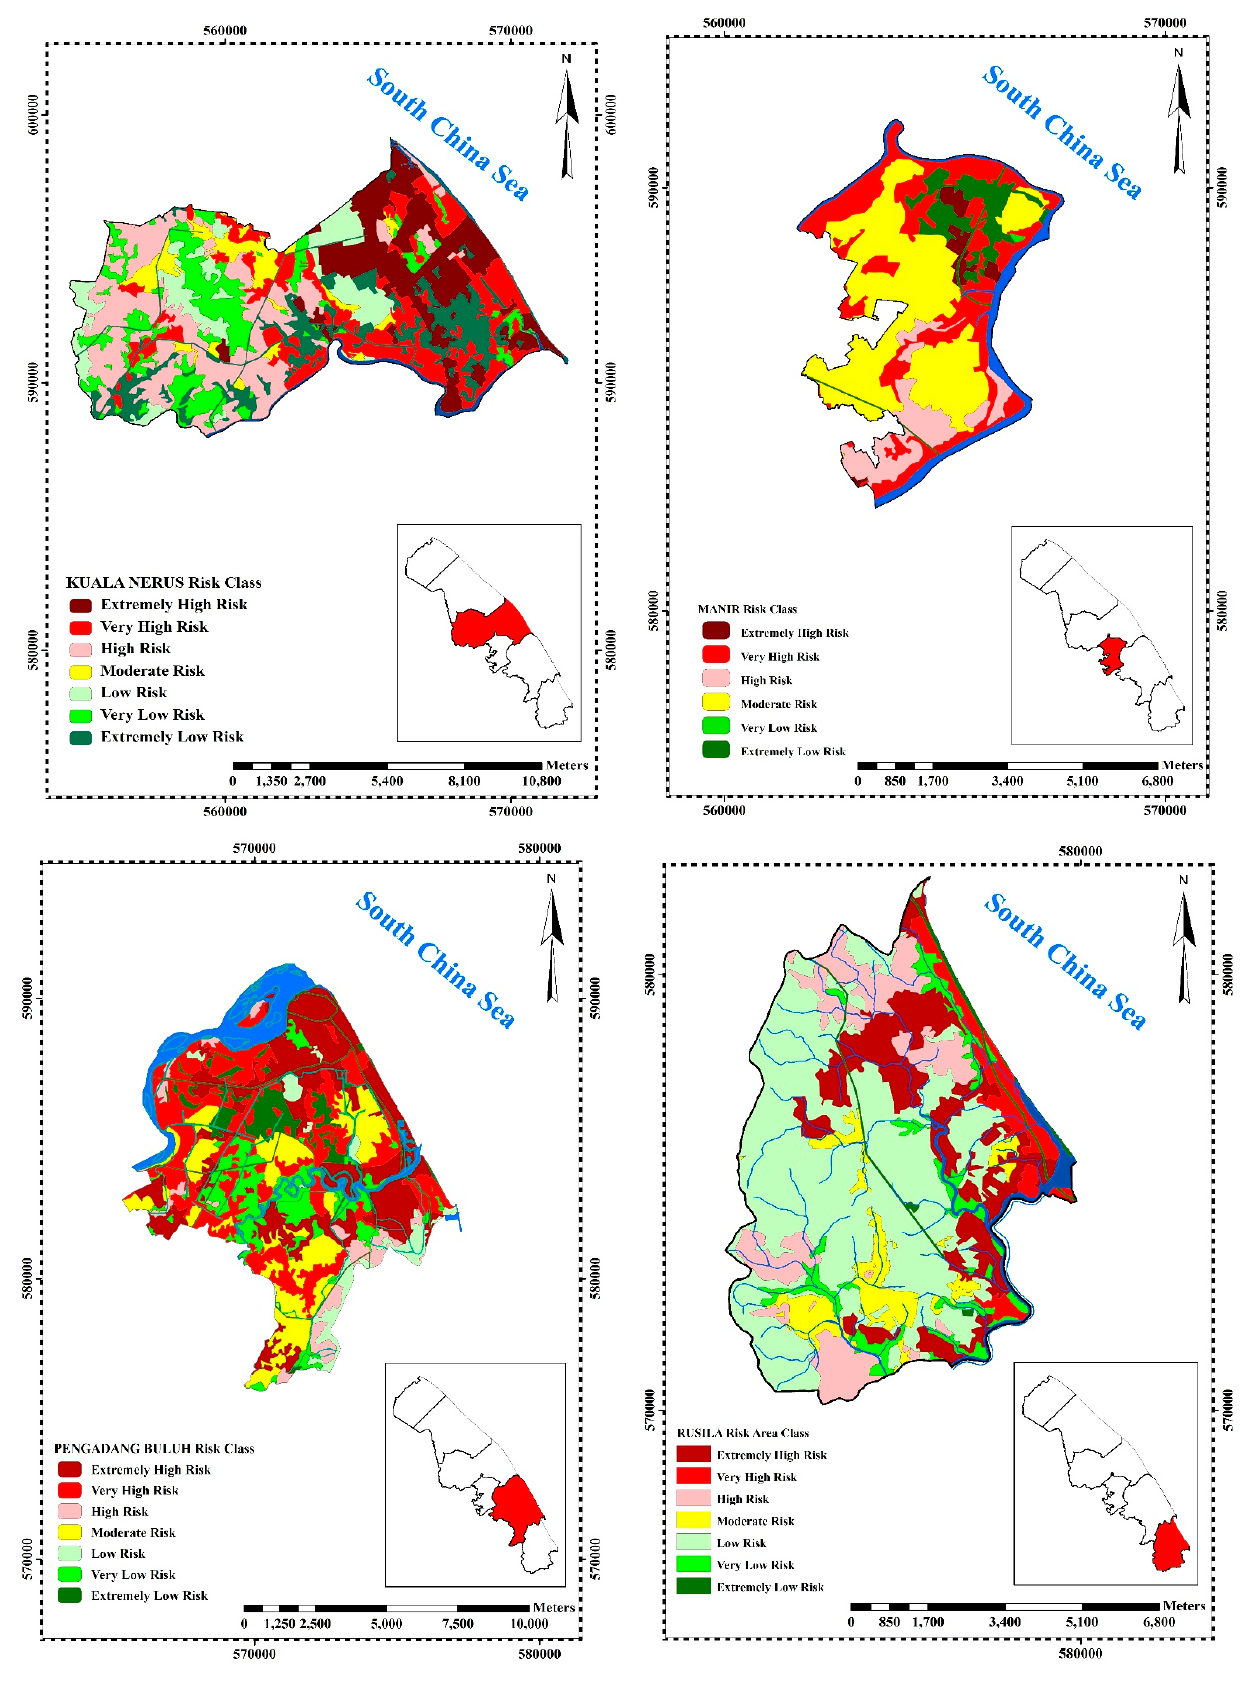
Figure 5. Final risk map and sensitive zones.